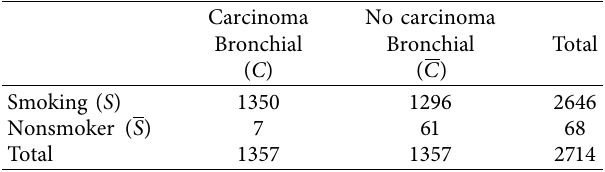
Table 6: The cross-distribution of smoking and bronchial carci- GK and OR hn in noma (source: Held [9] and Held et al